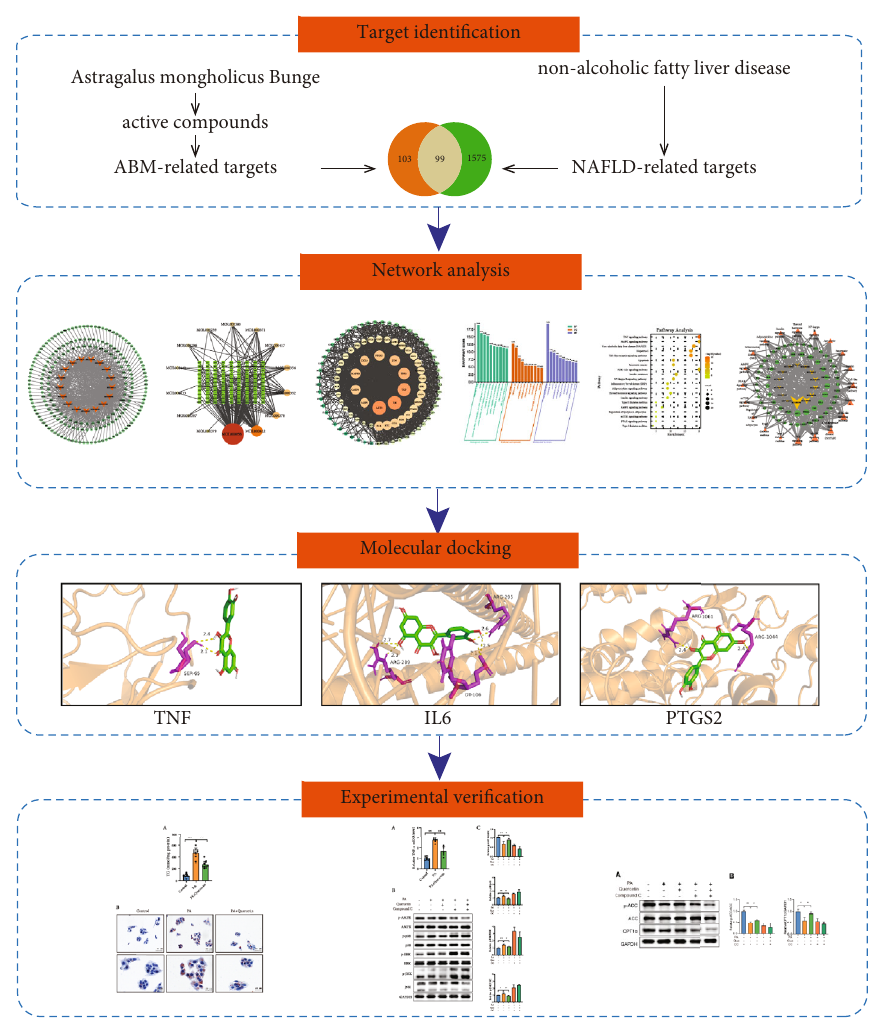
Figure 1: Flow chart of the pharmacological mechanisms of AMB against